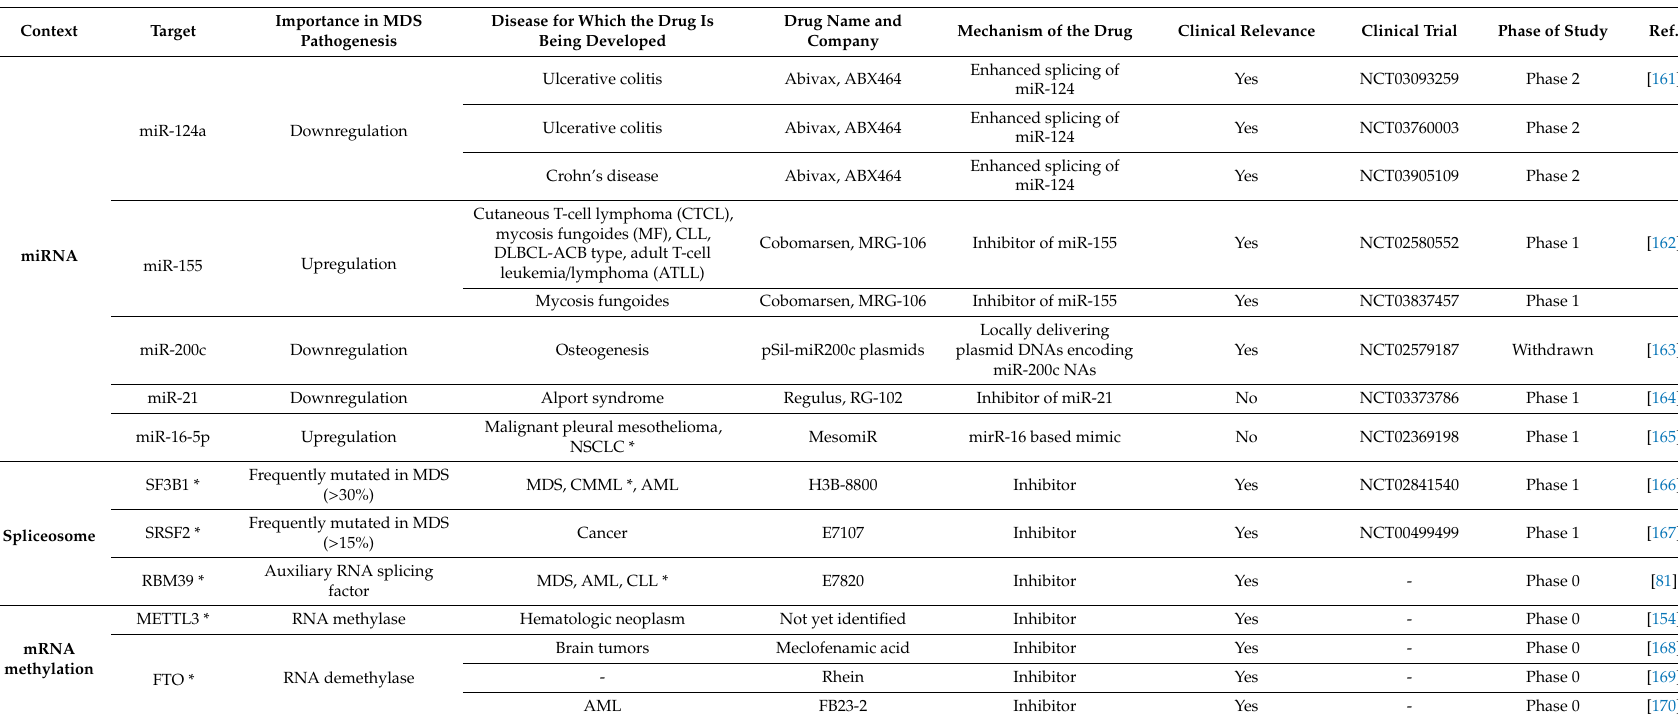
Table 4. A Snapshot of the Current Developmental Status of miRNA-Based and Connected Therapeutics in